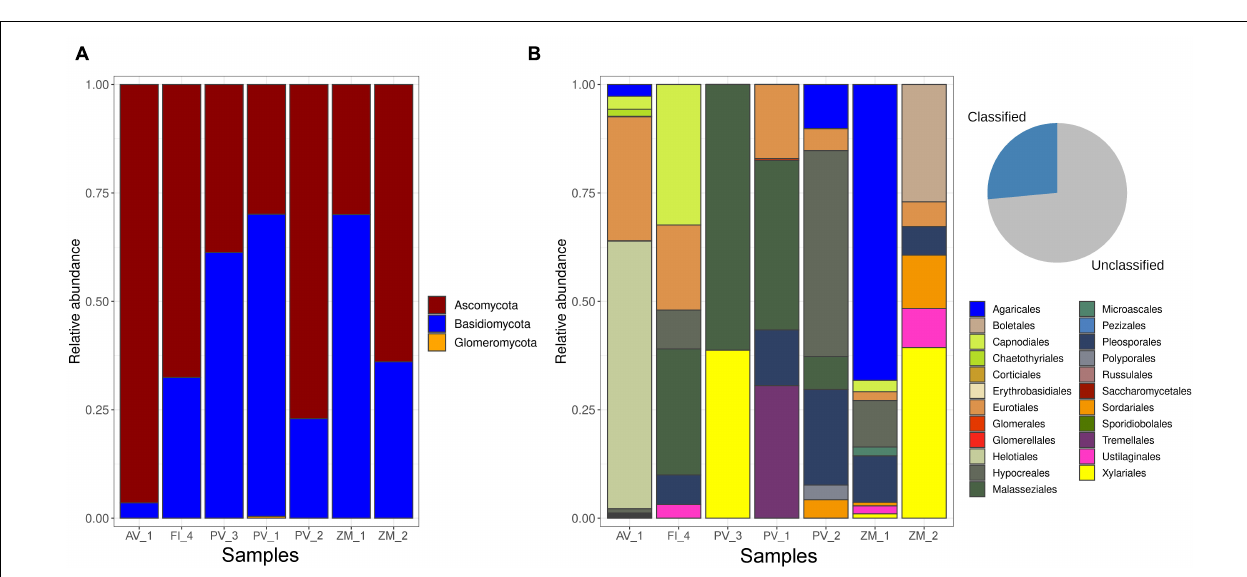
FIGURE 2 | Relative abundance of fungal phyla (A) , and orders (B) across